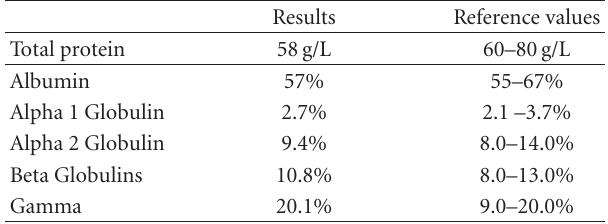
Table 6: Plasma electrophoresis directly after preparation.